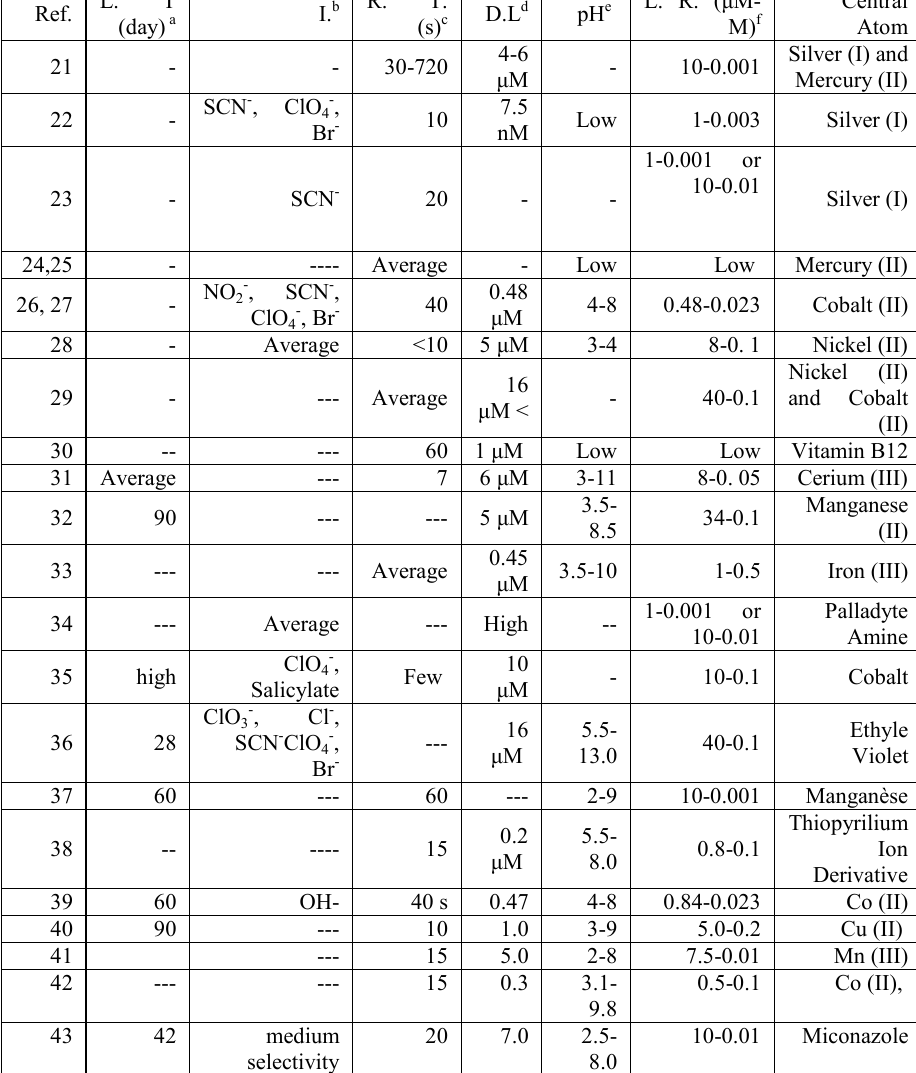
Table 5. Characteristic Performance of Some Iodide Selective